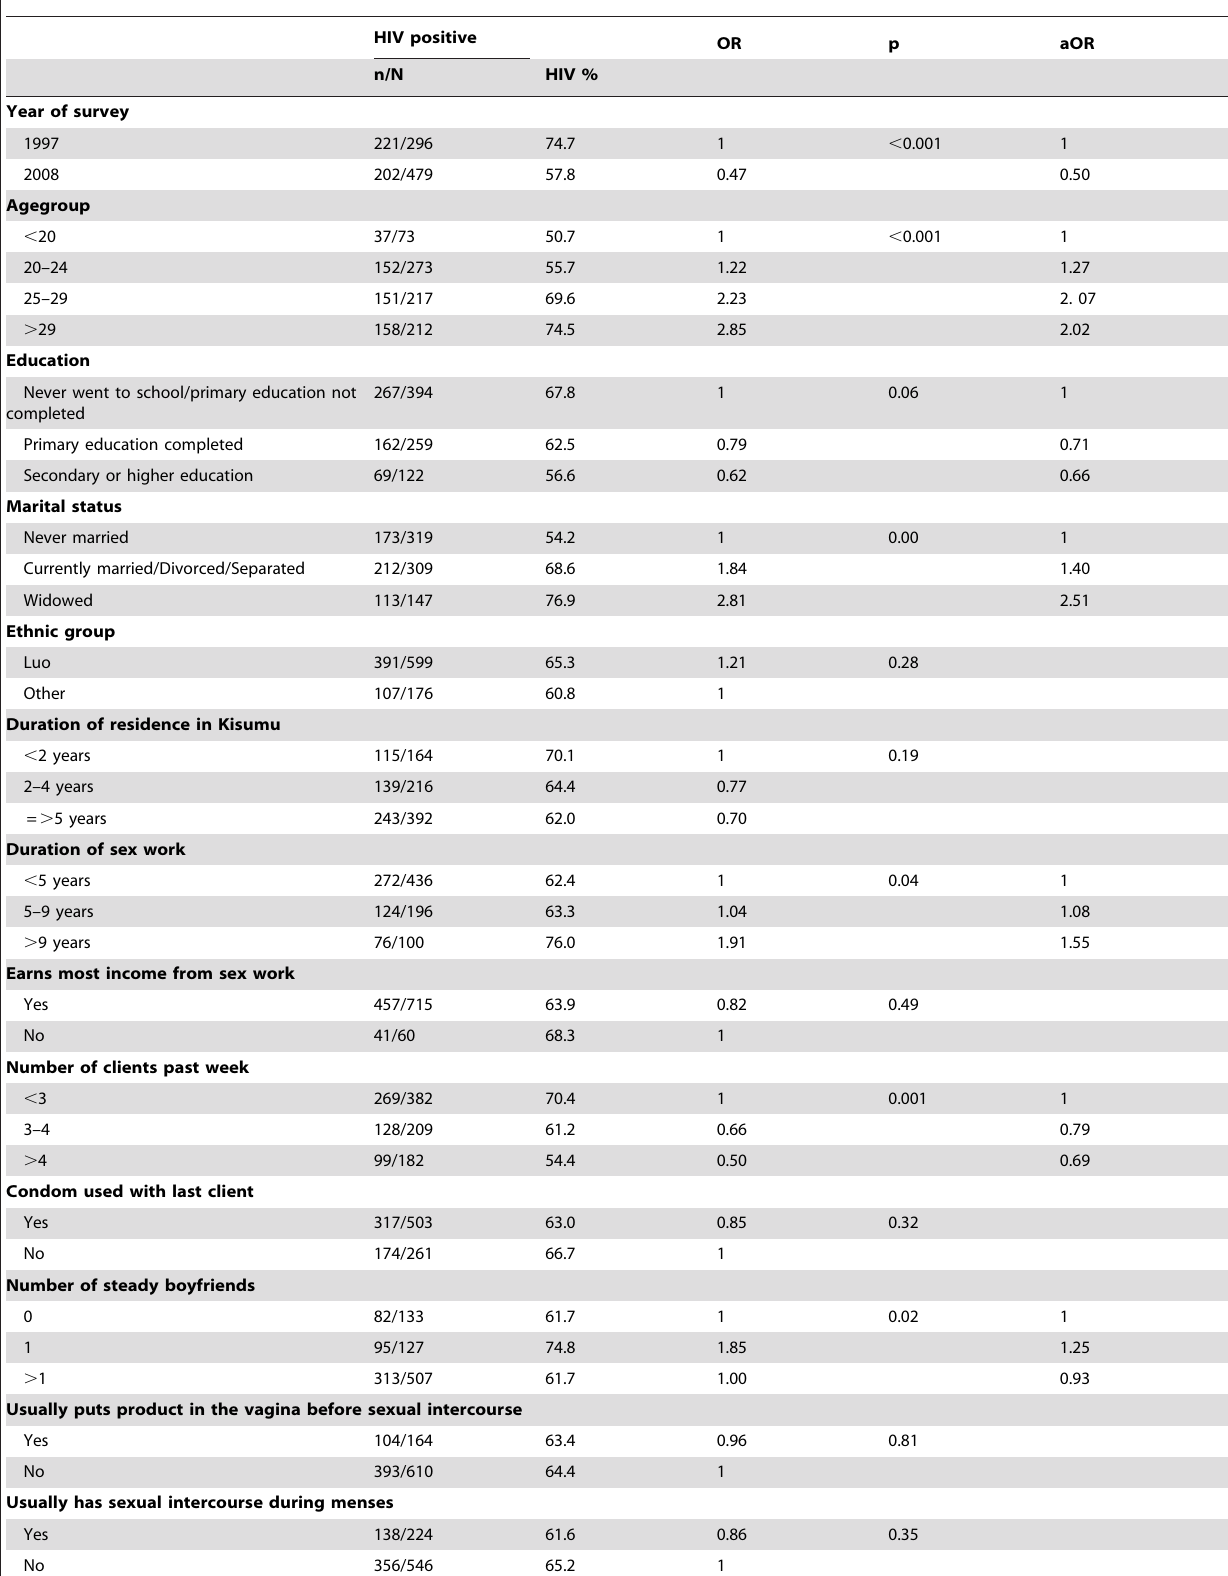
Table 5. Factors associated with HIV infection in FSW participating in the surveys of 1997 and 2008: bivariate and multivariate